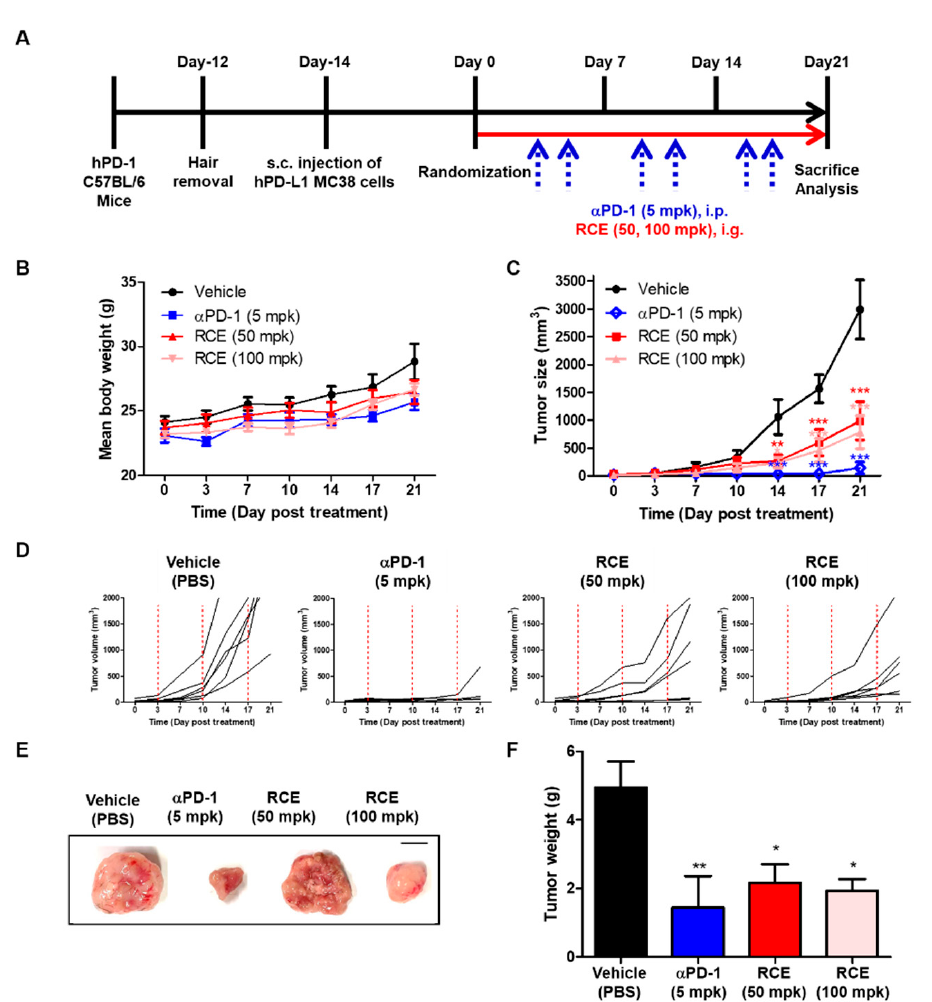
lines, therefore, we selected the hPD-L1 expressing MC38 tumor model for testing the in vivo e ffi cacy of RCE (Figure 2).